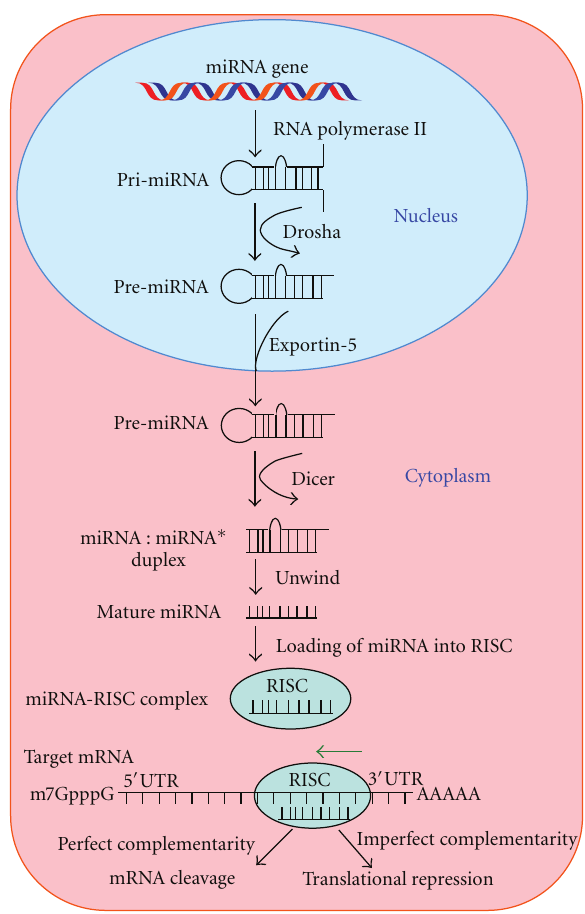
Figure 1: The biogenesis of microRNA in a cell. After the transcription of the miRNA gene in the nucleus, the primary transcript (pri- miRNA) is cleaved into a precursor molecule (pre-miRNA) with an imperfect stem-loop structure by Drosha. The pre-miRNA is exported from the nucleus into the cytoplasm by exportin-5. In the cytoplasm, the pre-miRNA is cleaved by Dicer into a dsRNA duplex (miRNA: miRNA ∗ ), which contains both the single-stranded mature miRNA and its complementary strand (miRNA ∗ ). The miRNA strand is then incorporated into the RNA-induced silencing complex (RISC) and targets the complementary mRNA sequences via translational repression or mRNA